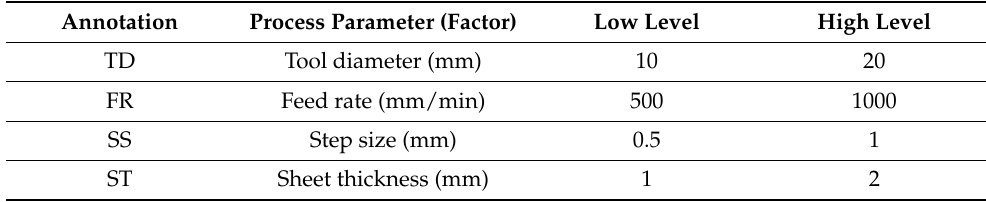
Table 3. Process parameters and their levels.